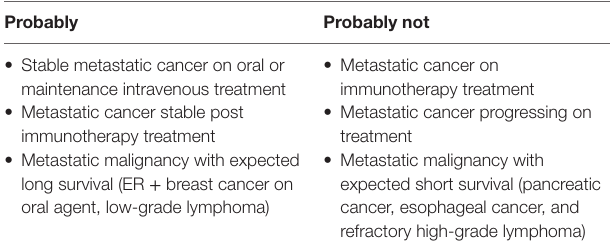
TABLe 2 | Patients who can be considered for a switch to direct oral